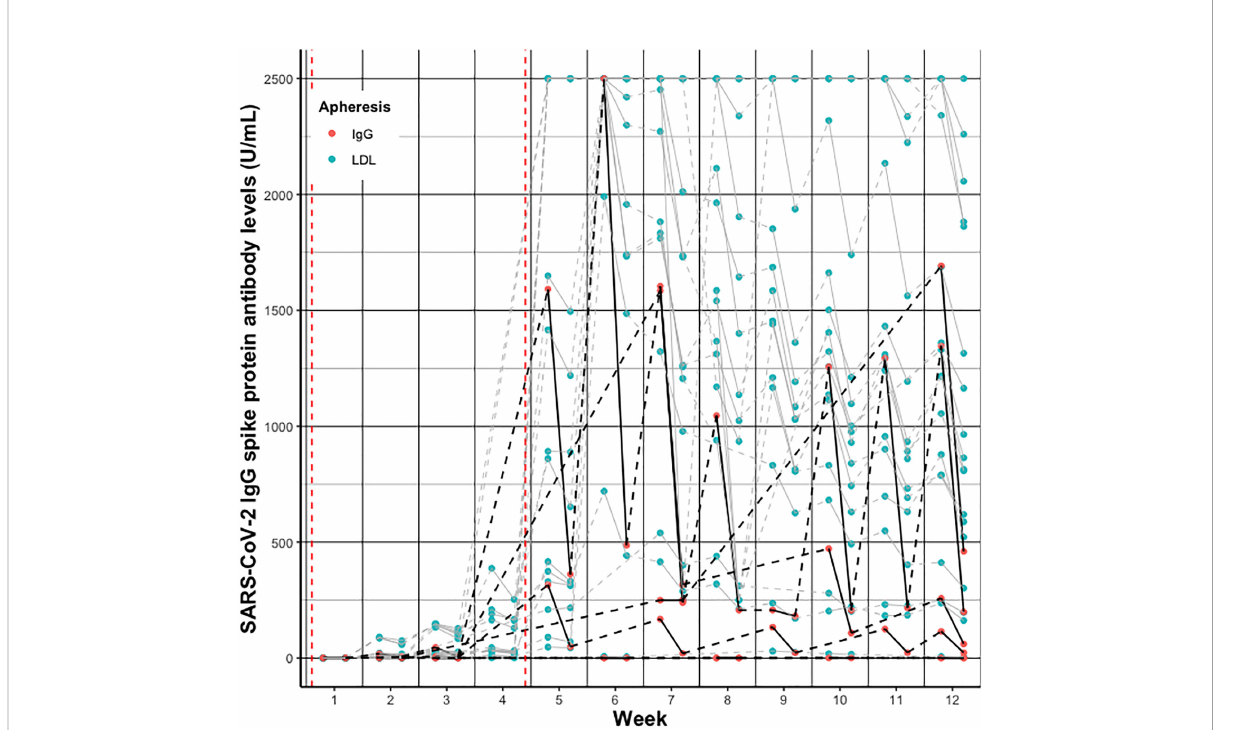
FIGURE 2 Individual change of SARS-CoV-2 IgG spike protein antibody levels pre- vs. post- vs. pre- treatment per week after vaccination in patients receiving IgG apheresis (black/red) and LDL apheresis (grey/blue). Solid lines indicate change from pre - to post -treatment levels, dashed lines indicate change from post- to next pre- treatment levels. Red dashed vertical lines indicate the fi rst and second vaccination,